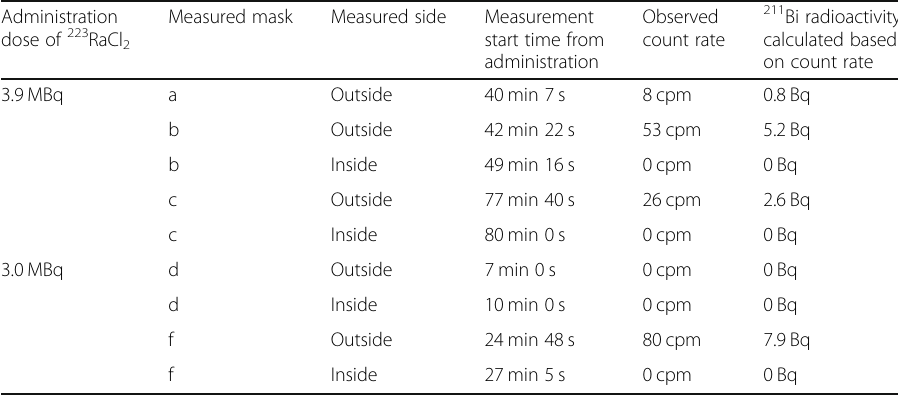
Table 2 Summary of measurement results obtained using an α survey meter for N95 masks worn by medical